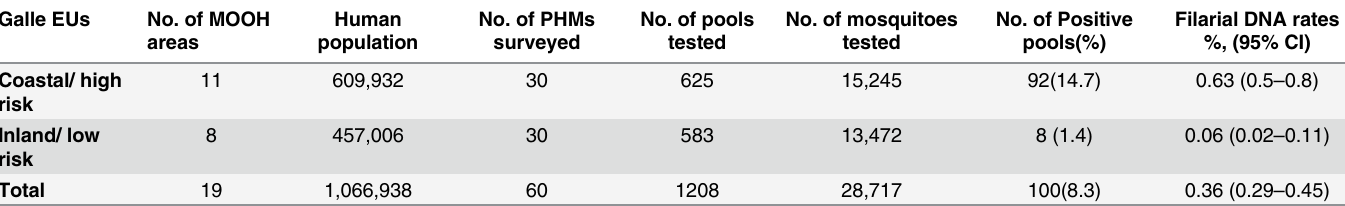
Table 1. Filarial DNA rates in Culex quinquefasciatus in 2 evaluation units (EU) in Galle district, Sri Lanka. Galle EUs